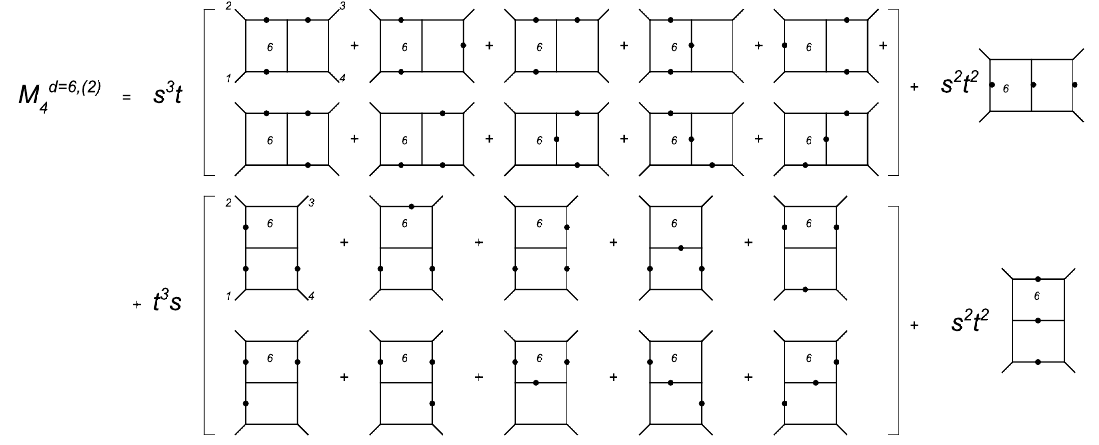
Figure 7 . The d = 6 two loop amplitude candidates, which iterates the one loop result in (cid:12)gure 6. The external momentum numeration is shown only on the (cid:12)rst diagram in each